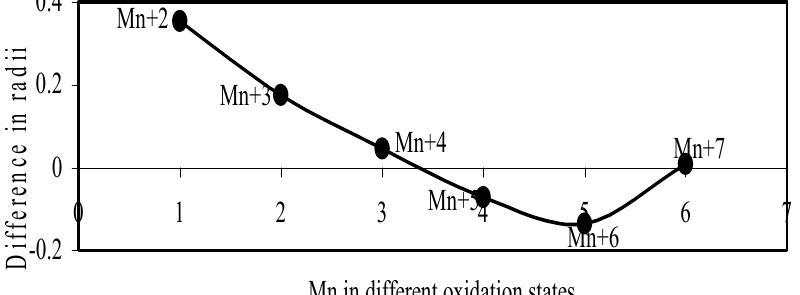
Figure 17. Plot of difference in experimental and theoretical radii of Mn in different oxidation